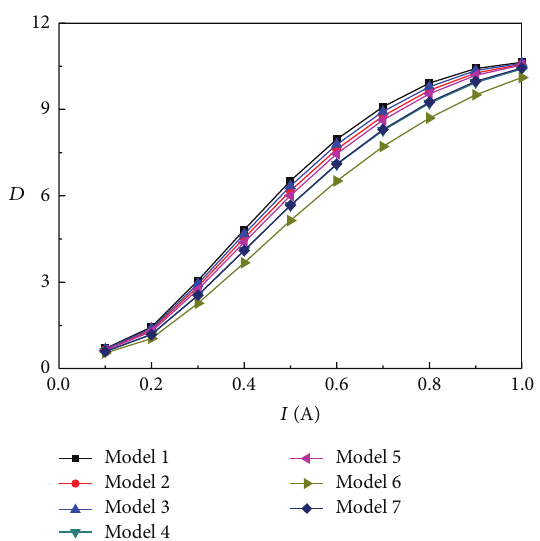
Figure 8: Dynamic range of MR damper under different